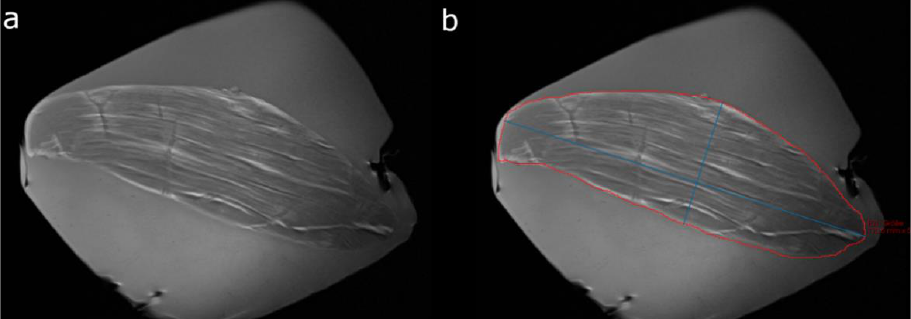
Figure 1. Sample case demonstrating semiautomated volume measurement of a porcine muscle specimen. ( a ) Paracoronal T1-weighted image of a porcine muscle specimen with a volume of 90 cm 3 as previously determined by the physical water displacement method. ( b ) Muscle specimen margins are manually traced (red outline) on each image slice of the data set using the mint Lesion TM software and automated 2D measurements (largest long axis dimension and perpendicular short axis dimension, blue lines) are automatically derived for each slice. The volume of the whole muscle specimen is then automatically calculated by the software.